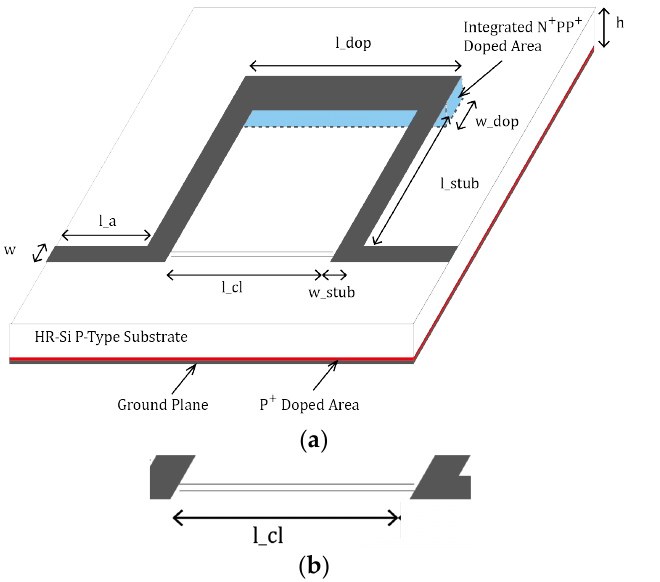
Figure 8. ( a ) Three-dimensional design of the 5 GHz reconfigurable filter. ( b ) Zoom on the coupled lines.